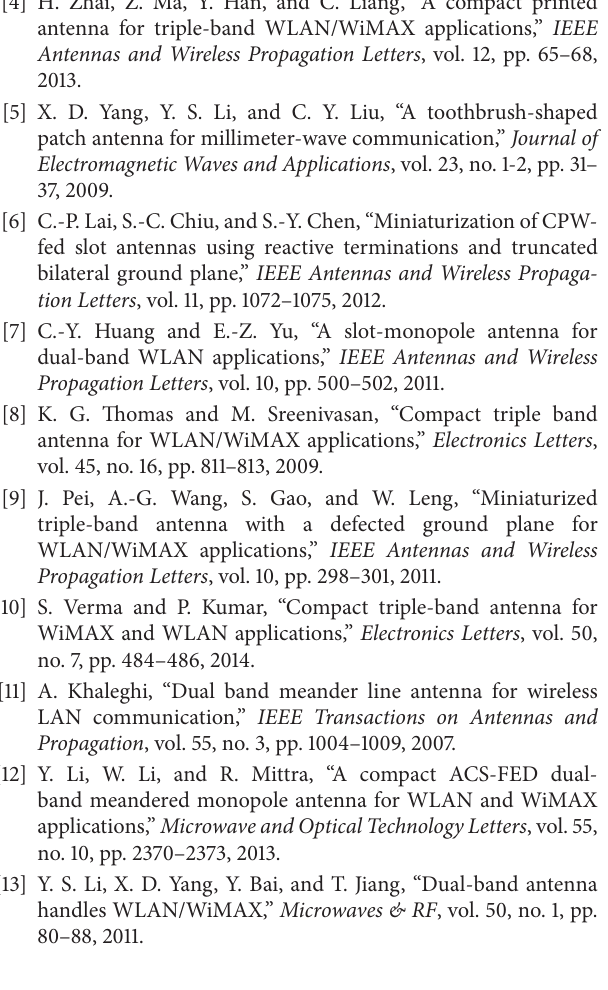
Table 1: Comparisons of several existing multiband